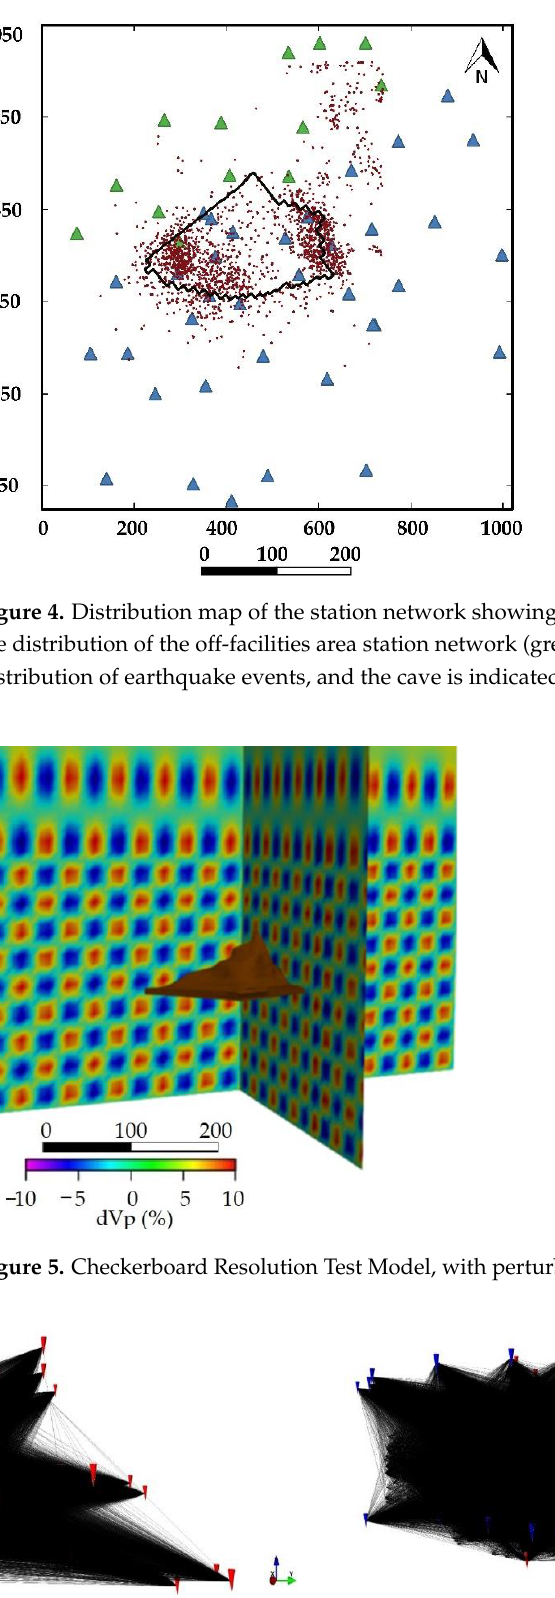
Figure 4. Distribution map of the station network showing the mining facilities (blue triangles) and the distribution of the off-facilities area station network (green triangles). The black dots indicate the distribution of earthquake events, and the cave is indicated by a black triangle.